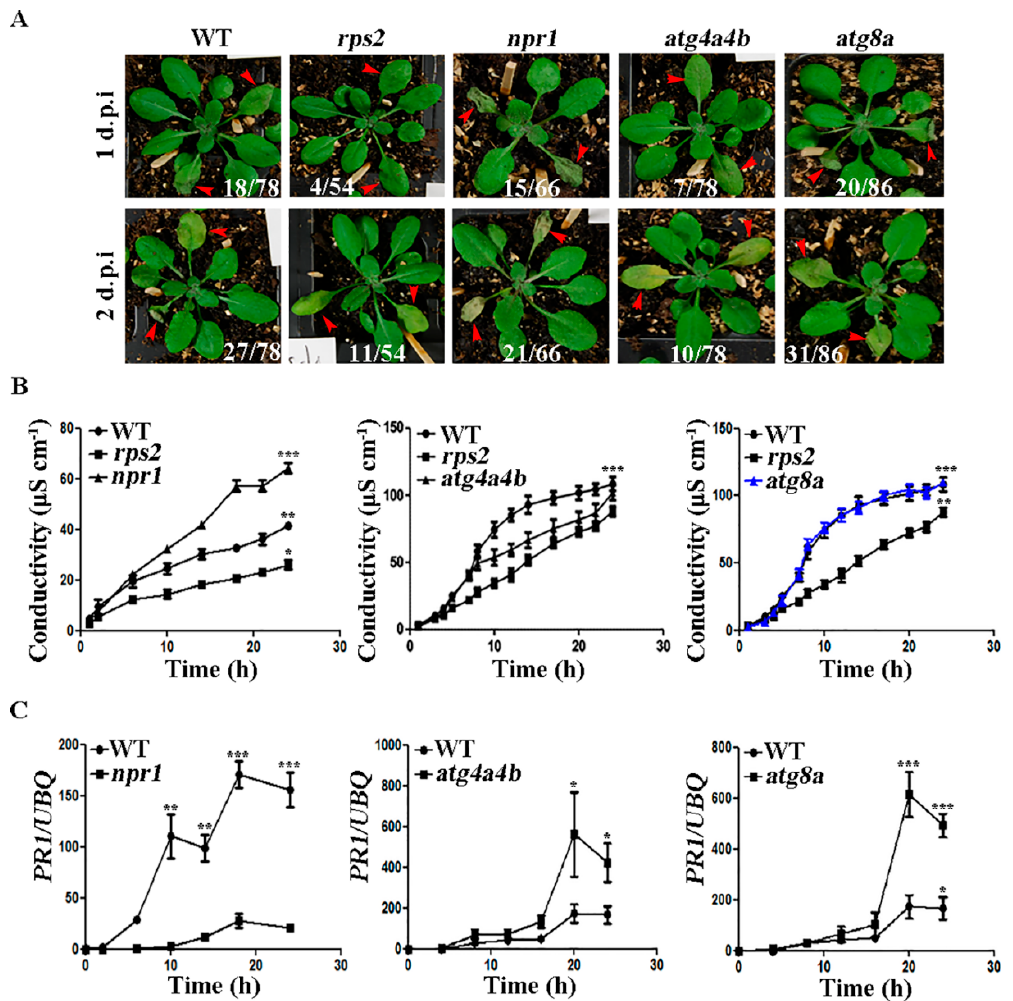
Figure 3. ATG4 inhibited the occurrence of hypersensitive response (HR) during AvrRpt2 infection. ( A ) Phenotypes of WT, rps2, npr1, atg4a4b and atg8a after AvrRpt2 infiltration for 1 or 2 days. Numbers are ratios of leaves with HR phenotype. ( B ) Ion leakage assay in WT, rps2 , npr1 , atg4a4b and atg8a when infected with AvrRpt2 . ( C ) Quantitative RT-PCR data showed the expression of pathogenesis-related (PR1) in WT, npr1 , atg4a4b and atg8a when infected with AvrRpt2 . Each value is the mean ± SD of three replicates. Statistically significant differences between treatments (* p < 0.05, ** p < 0.01 and *** p < 0.001).